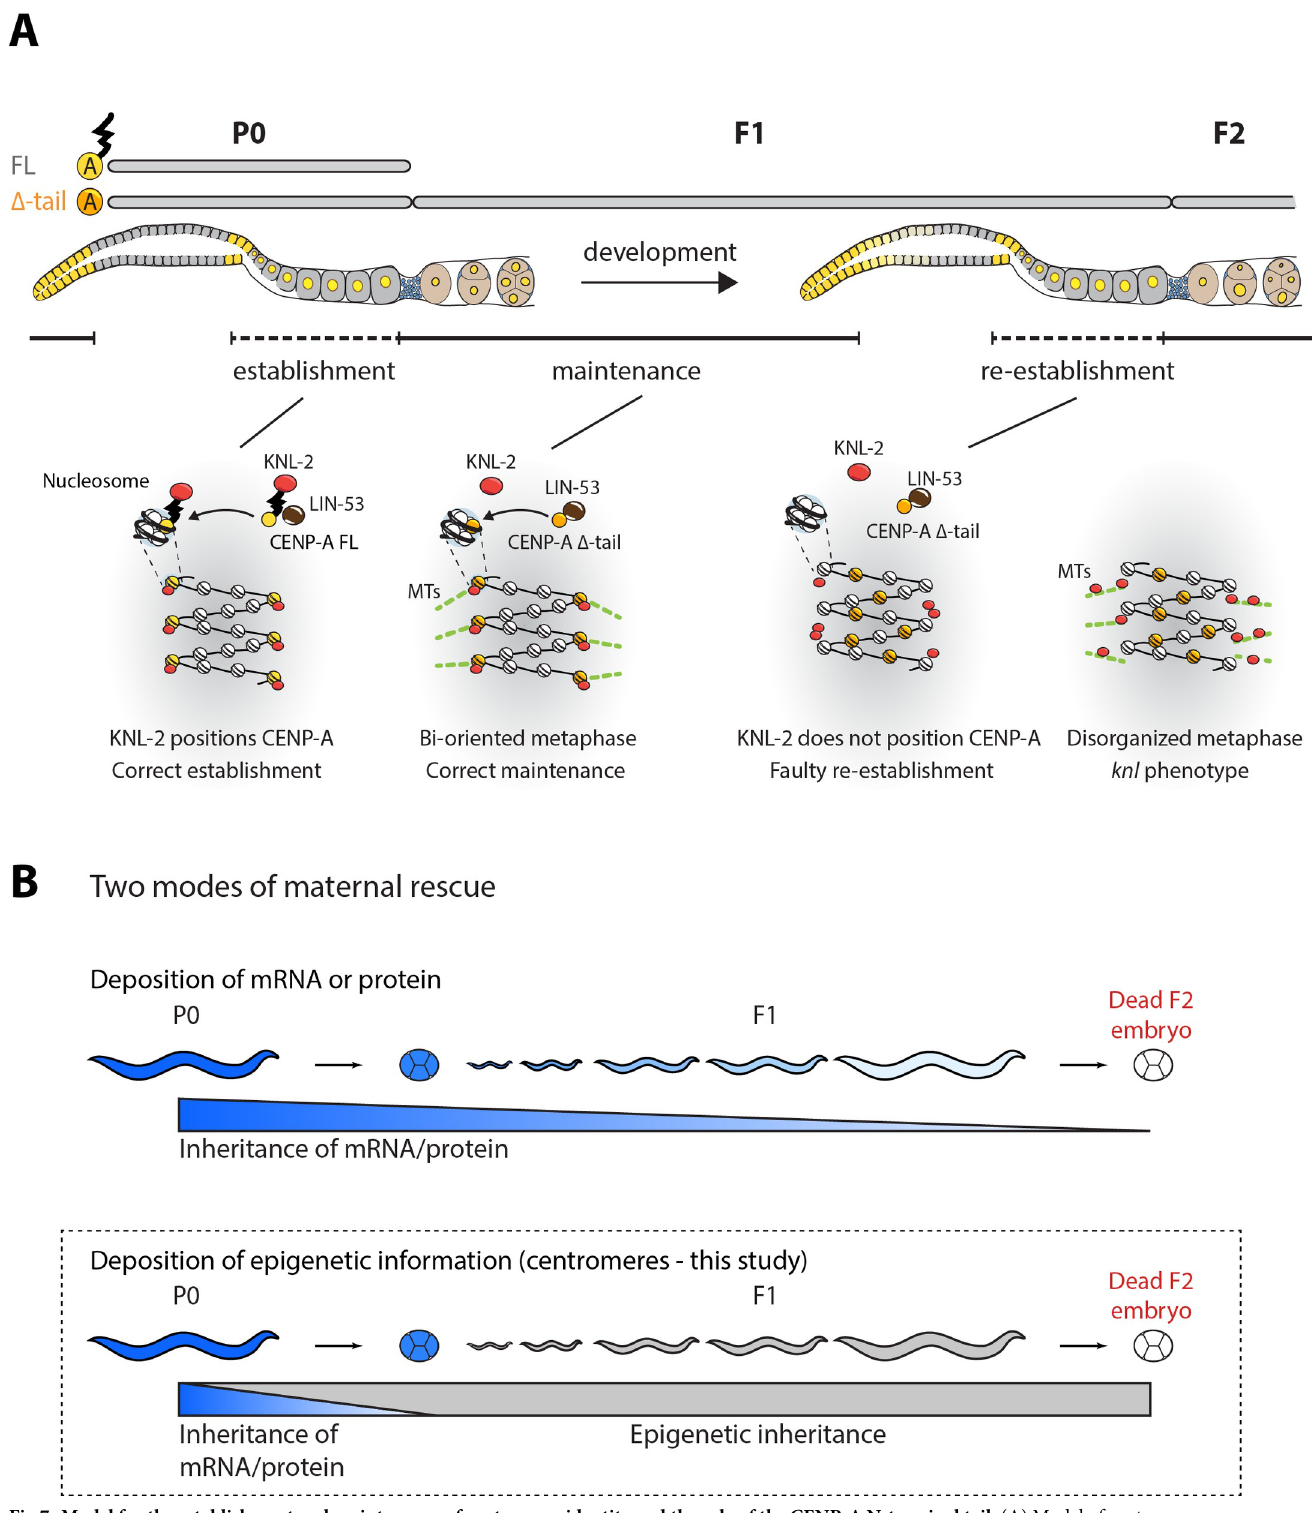
Fig 7. Model for the establishment and maintenance of centromere identity and the role of the CENP-A N-terminal tail. (A) Model of centromere establishment and maintenance across generations in C . elegans . Centromeres are established in the proximal germ line and maintained until their removal in the distal germ line of the next generation. The CENP-A N-terminal tail interacts with KNL-2 and is required for establishing centromeres. The presence of CENP-A on